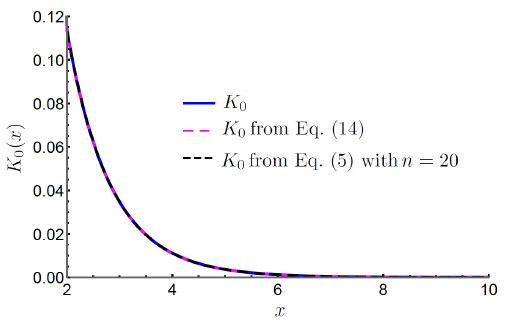
Figure 3. Plot of Equations (14) and (5), up to O ( x 20 )